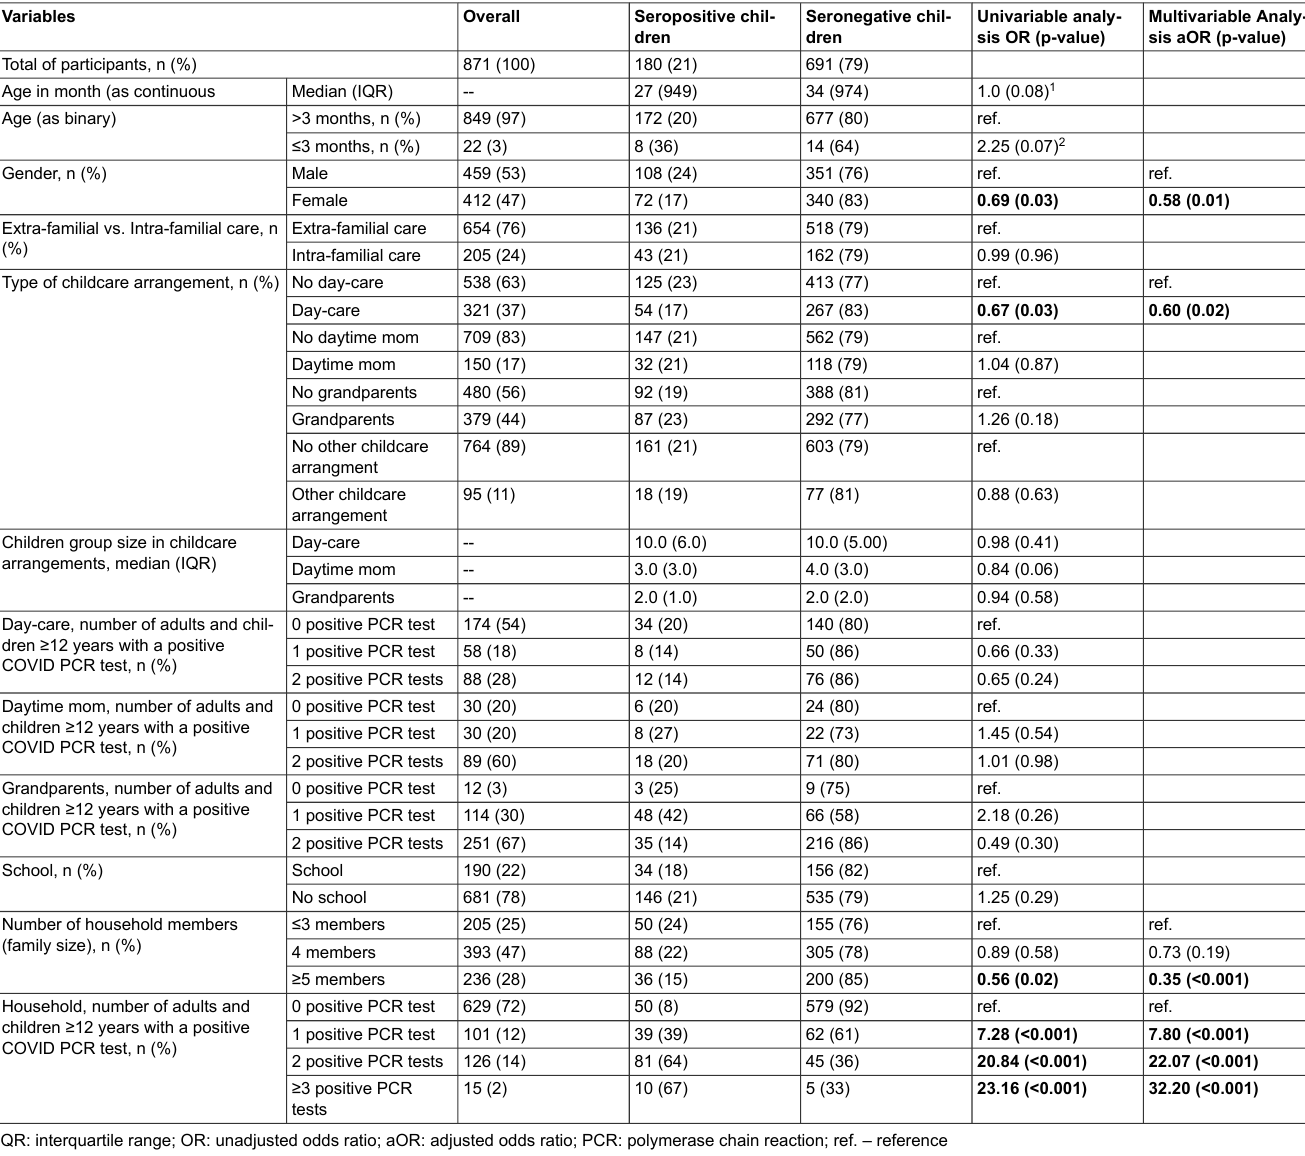
Table 2: Data summary and logistic regression analysis comparing seropositive versus seronegative SARS-CoV-2 in children less than 6 years of age.